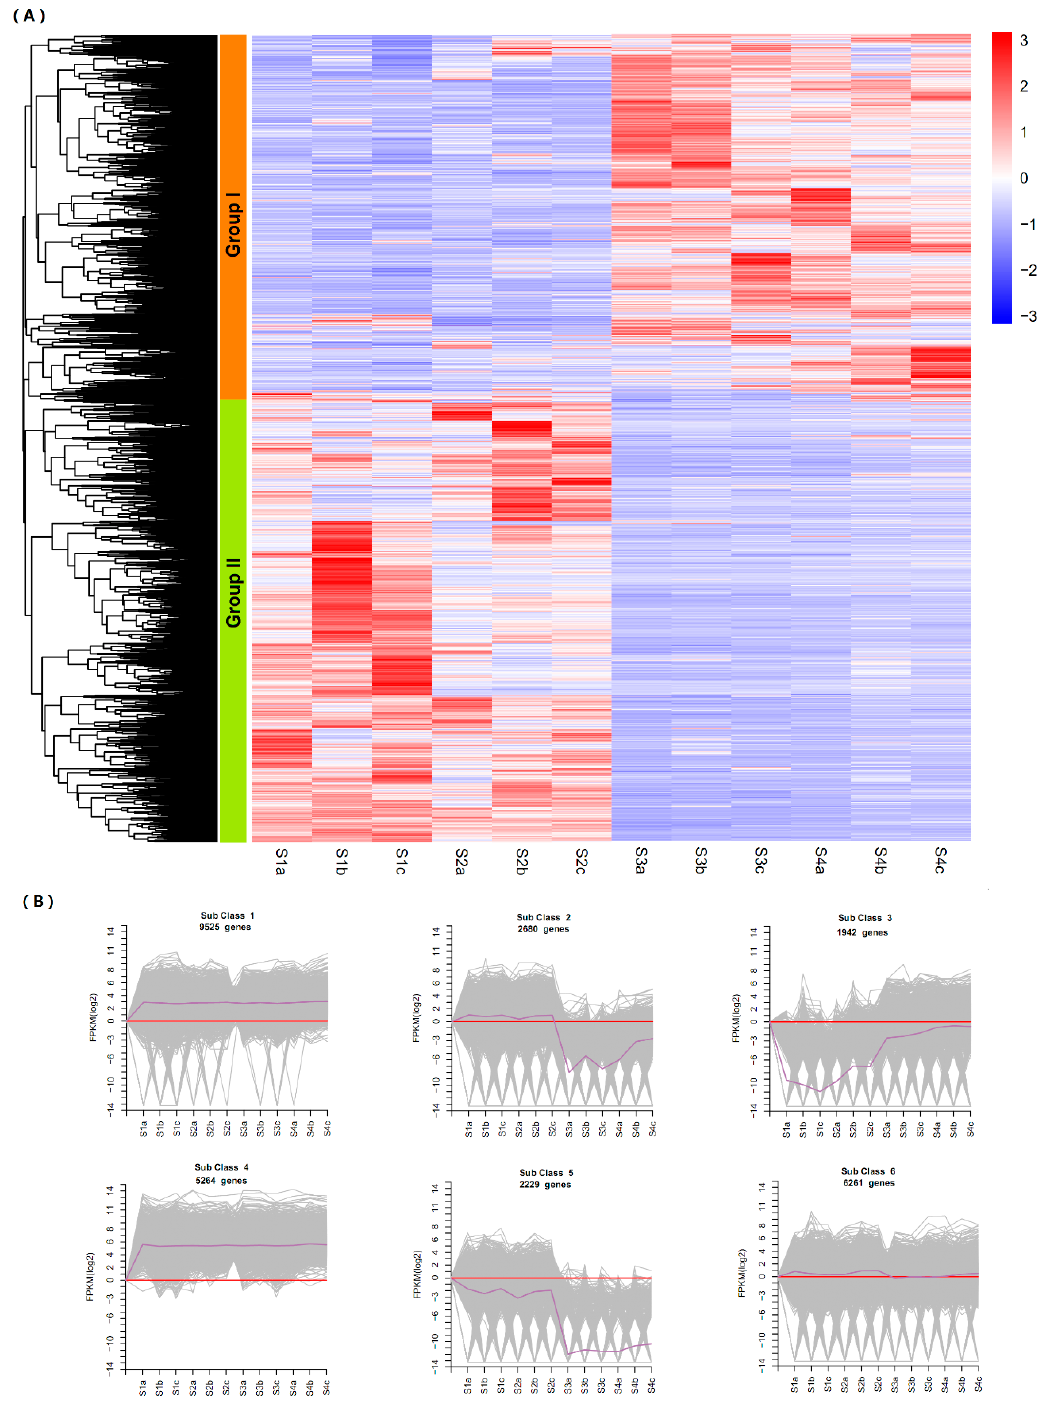
Figure 4. DEGs at four stem swelling stages in stem mustard. ( A ) Hierarchical clustering of DEGs for all samples. ( B ) K-mean clustering of gene expression trends. The expression profile of each gene in each cluster is shown as a gray line, and the average expression profile of all genes in each sample is shown as purple.